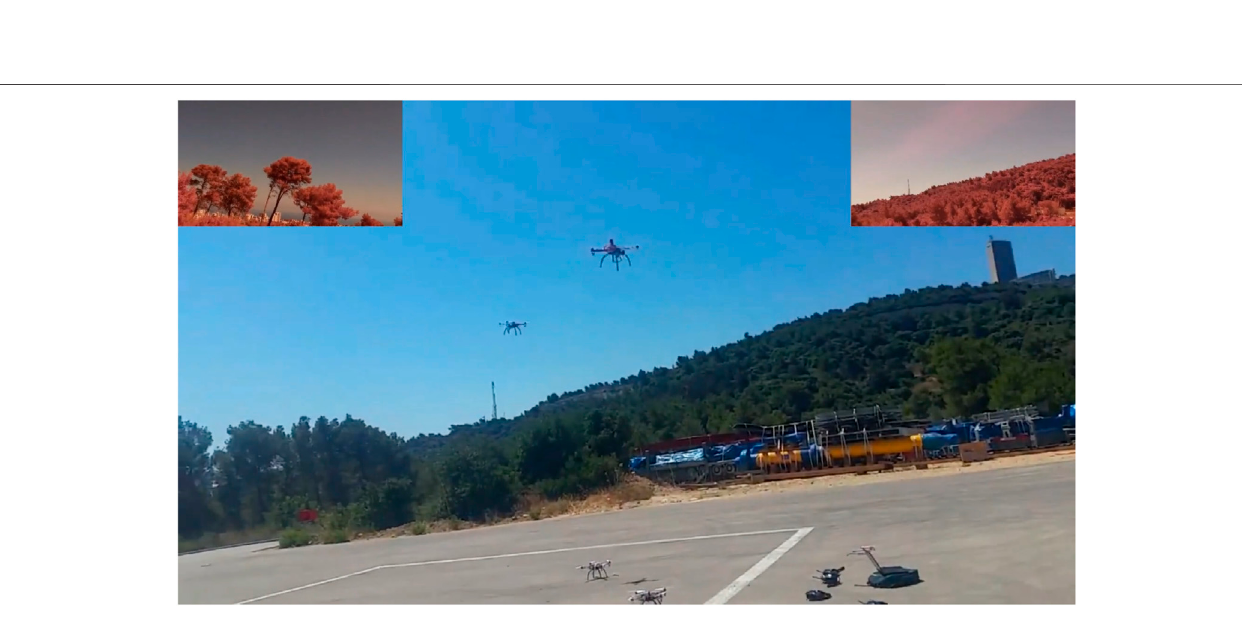
Frontiers in Robotics and AI |